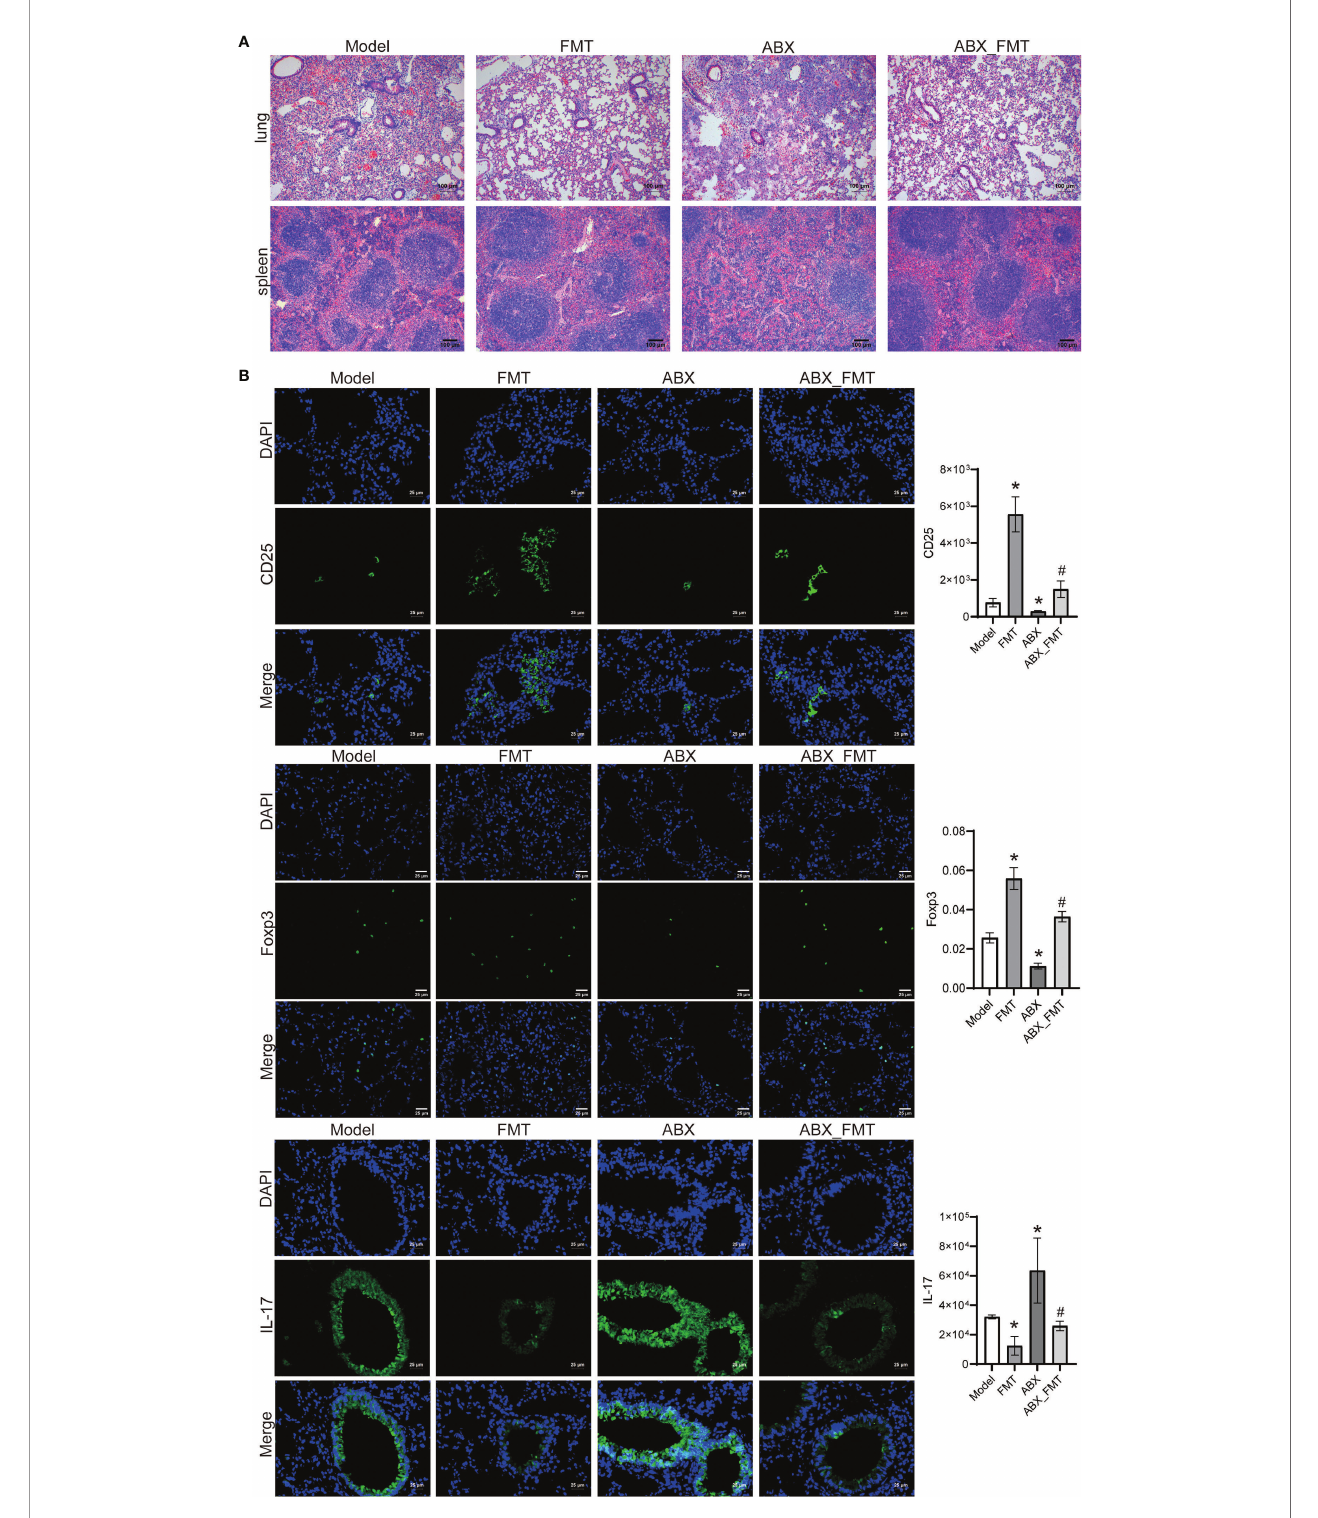
FIGURE 8 | FMT improved tissue injury and immunity in mice with acute pneumonia (n=10 mice/group). (A) HE staining was used to observe the pathological injury of lung and spleen tissues (100×). (B) The expression of CD25, Foxp3 and IL-17 in lung tissues were detected by Immuno fl uorescence (400×). *P < 0.05 vs control group; #P < 0.05 vs ABX group. Each sample was replicated 3